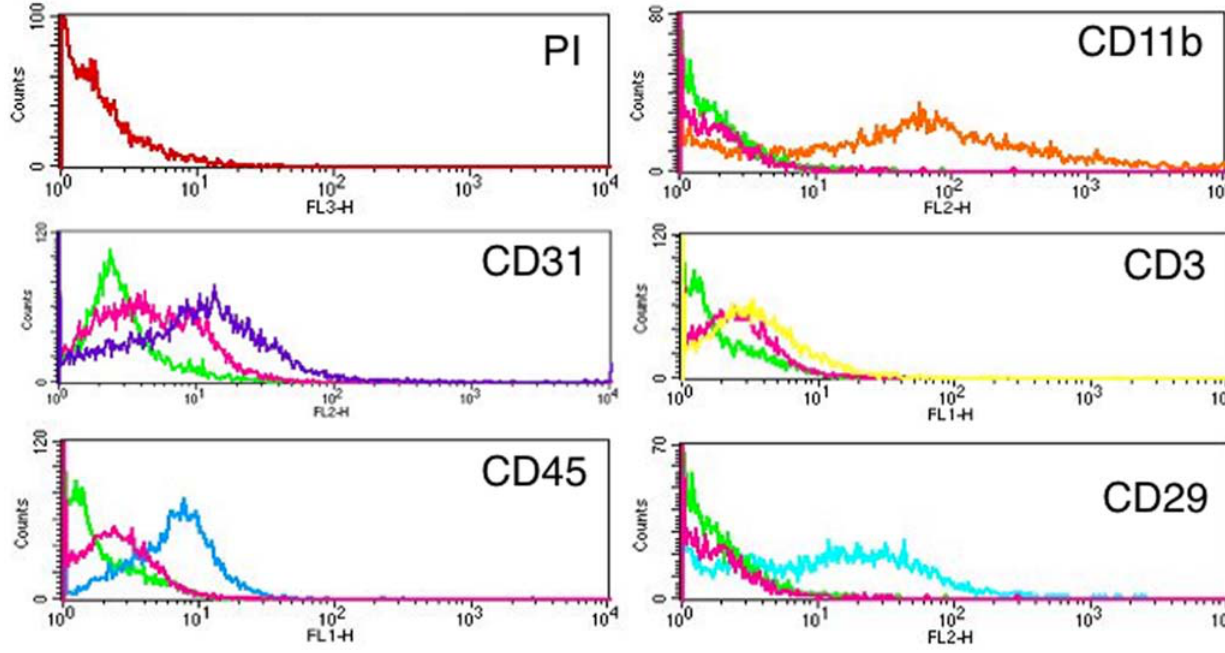
Figure 3. Matrigel TM plaque cell content harvested on day seven post-implantation. Flow cytometry histograms revealing live, propidium iodide (PI) negative cells expressing CD31, CD45, CD11b and CD3. Human BMSCs were detected by staining for CD29. Green lines indicate unstained cells, while pink lines cells stained with appropriate isotype antibodies.